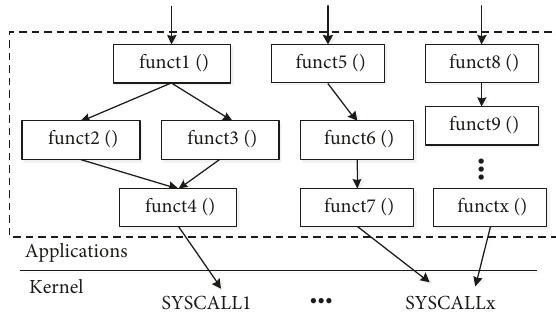
Figure 2: An example of the function calling tree.